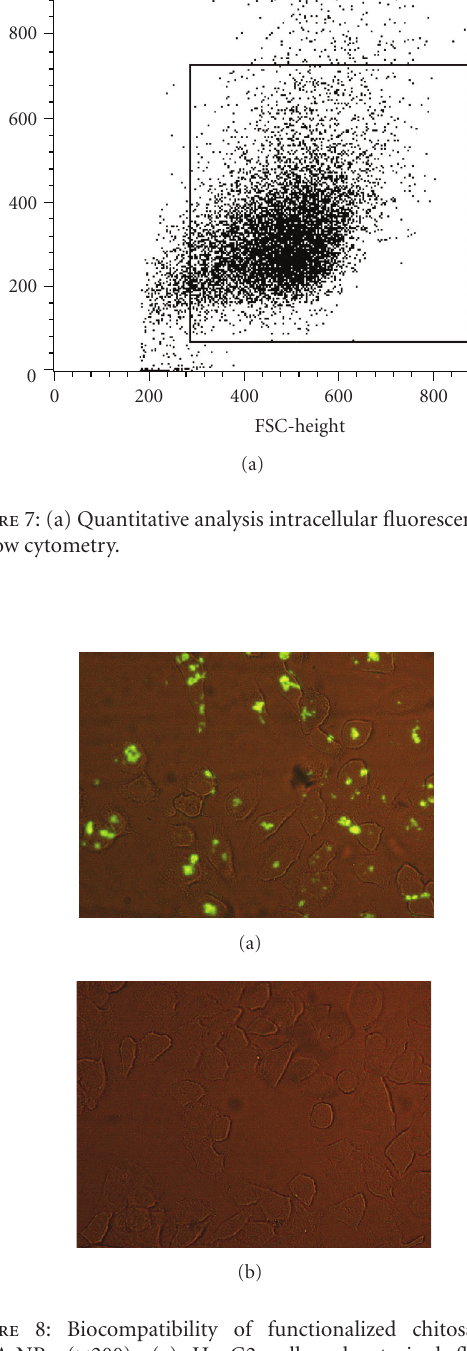
Figure 8: Biocompatibility of functionalized chitosan-coated PBCA-NPs ( × 200). (a) HepG2 cell endocytosised fluorescent chitosan-coated PBCA-NPs; (b) HepG2 cell without fluorescent chitosan-coated